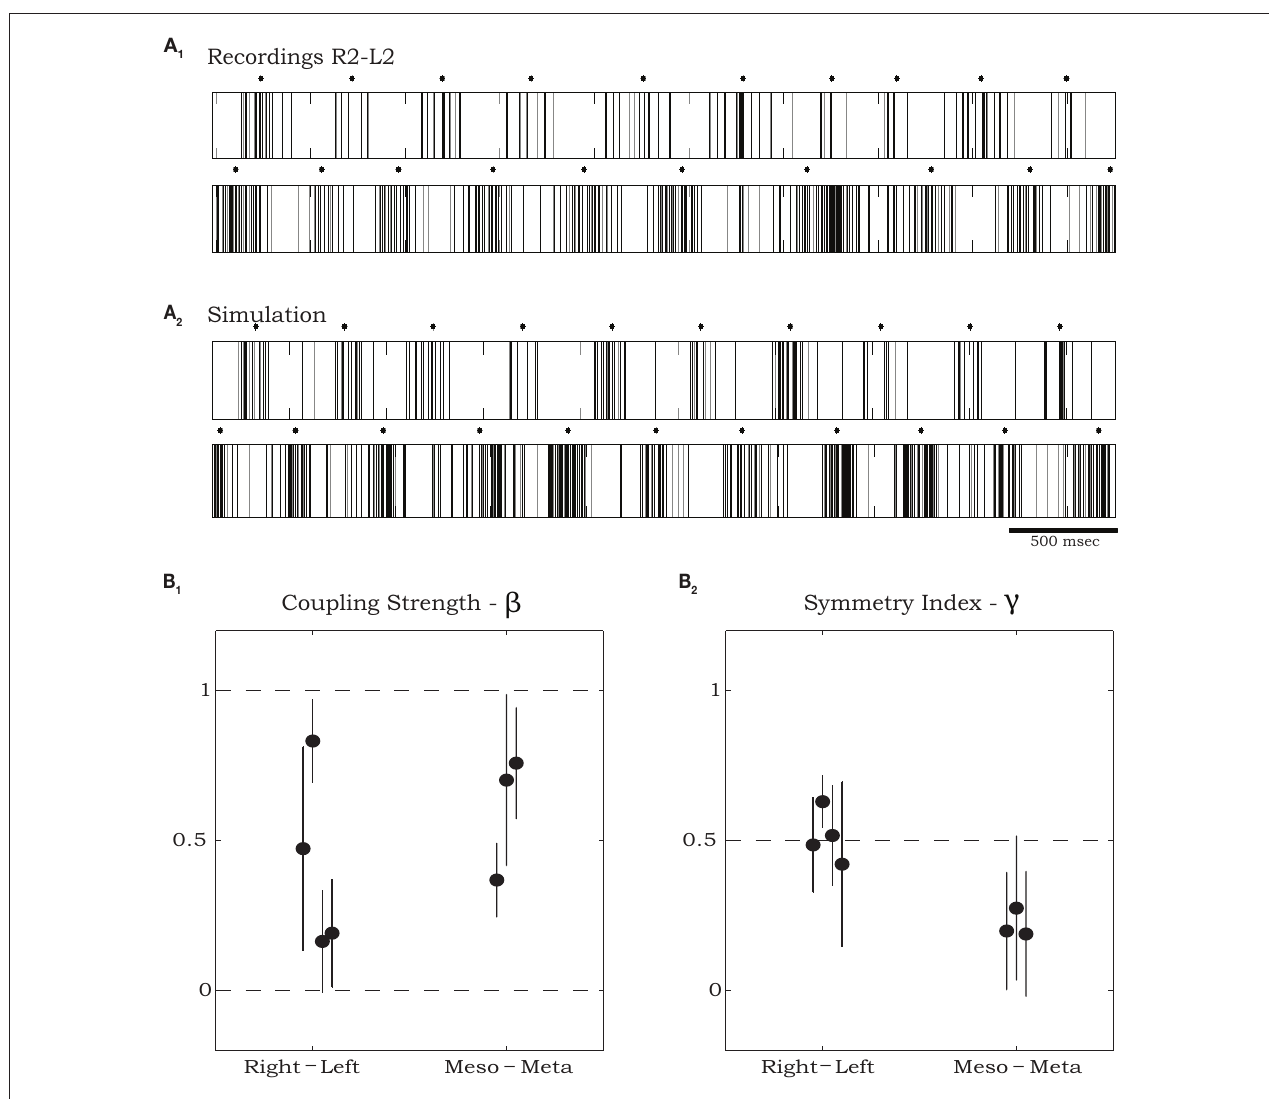
Figure 5 | estimating parameters of recorded sequences using simulations of the stochastic phase model. (A) An example of spike train recordings from R2 and L2 (A ) , and corresponding spike trains of a simulated 1 model (A ) with parameters that best fit the data shown in (A ) . Black dots in 2 1 (A ) and (A ) mark burst centers. Model parameters were: ω = 1.025 Hz, 1 2 01 = 1.146 Hz, ω = − 0.152 Hz, ω = 0.252 Hz, ω = 0.408 Hz, ω = 0.871 Hz, ω 02 11 12 21 22 σ